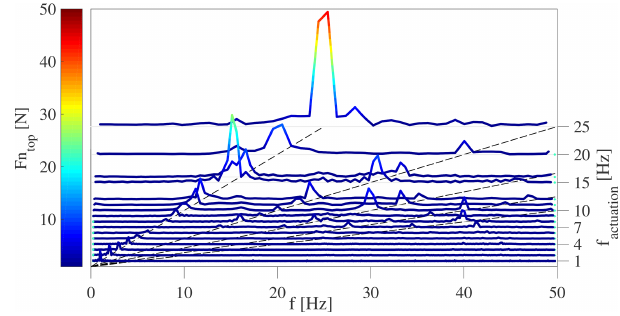
Figure 5. Waterfall diagram of the normal force at different actua- tion frequencies for the trailing-edge flap ( y axis). The experiment was conducted with the tunnel speed set to u ∞ = 15m /